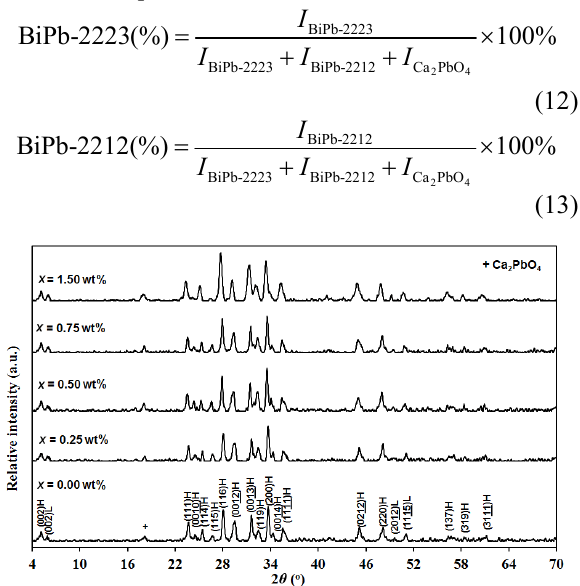
Fig. 2 XRD patterns for (BaSnO 3 ) x /BiPb-2223 (0 ≤ x ≤ 1.50 wt%) samples.